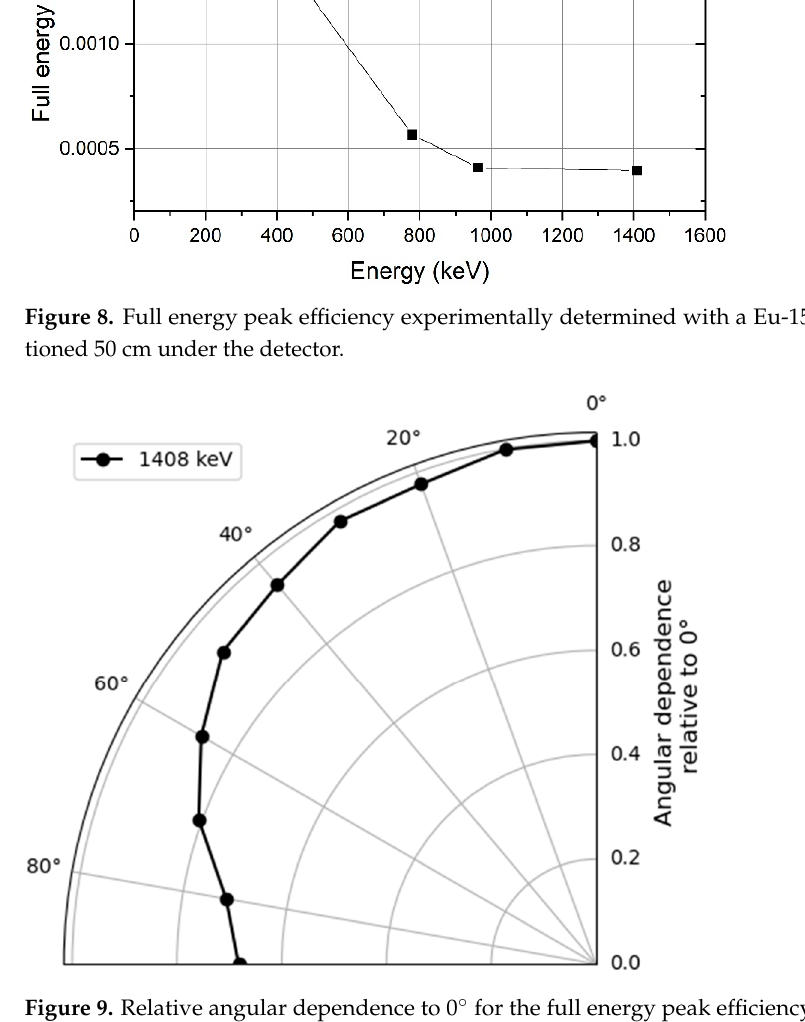
Figure 9. Relative angular dependence to 0° for the full energy peak efficiency of 1408 keV from a Eu-152 point source.